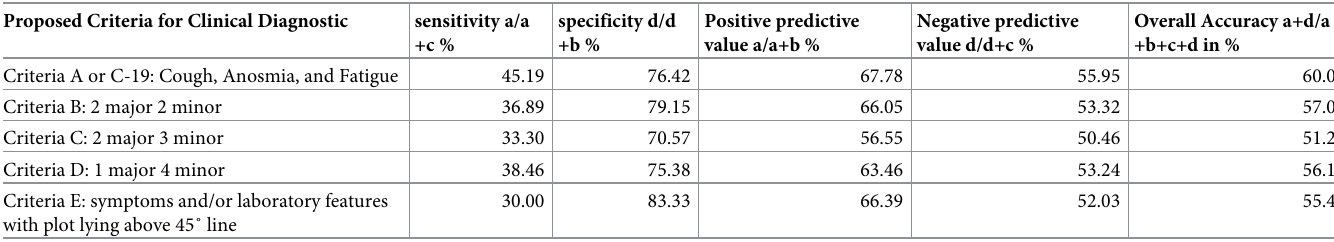
Table 8. Clinical diagnostic accuracy for each